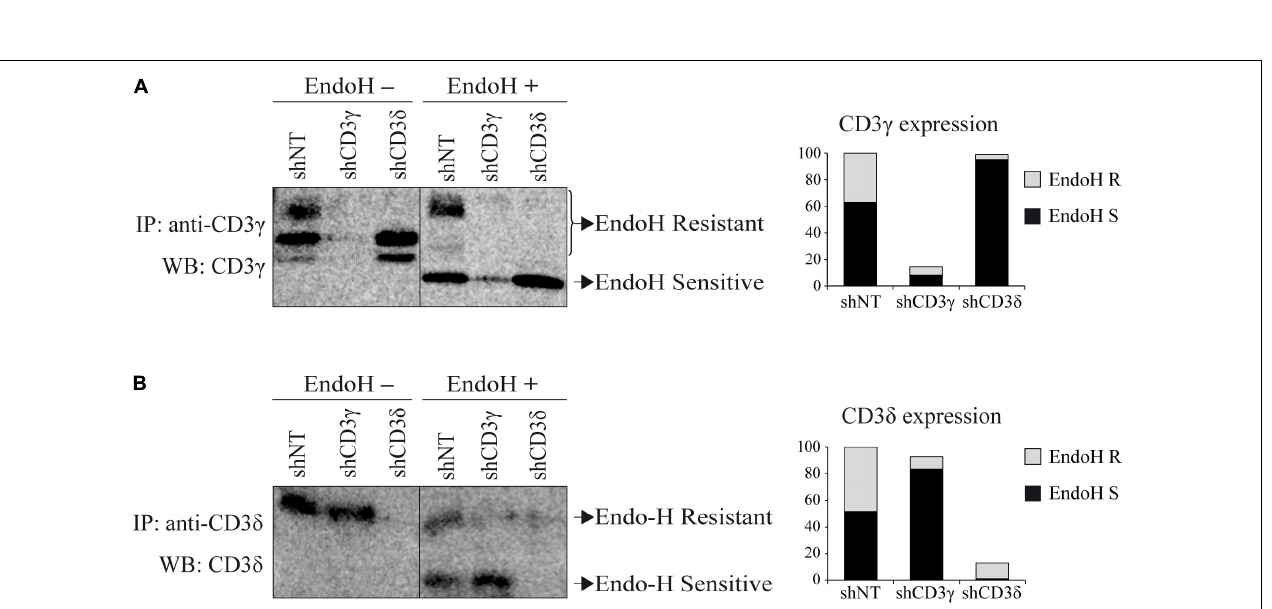
FIGURE 4 | EndoH sensitivity of CD3 chains in CD3G or CD3D KD T-cell lines. (A) Cells were lysed in Brij96V buffer and immunoprecipitated with anti-CD3 γ (HMT3.2). Half of the immunoprecipitated proteins were treated with EndoH. Samples were analyzed in 15% SDS-PAGE gels and immunoblotted with anti-CD3 γ antibody (Abcam). The graph represents the quantification of EndoH-resistant (R, Golgi-associated) and EndoH-sensitive (S, ER-associated) species. (B) Cells were immunoprecipitated with anti-CD3 δ (APA1/2) antibody and immunoblotted with anti-CD3 δ (Abcam). Sample preparation, treatment with EndoH, and analysis as in (A)